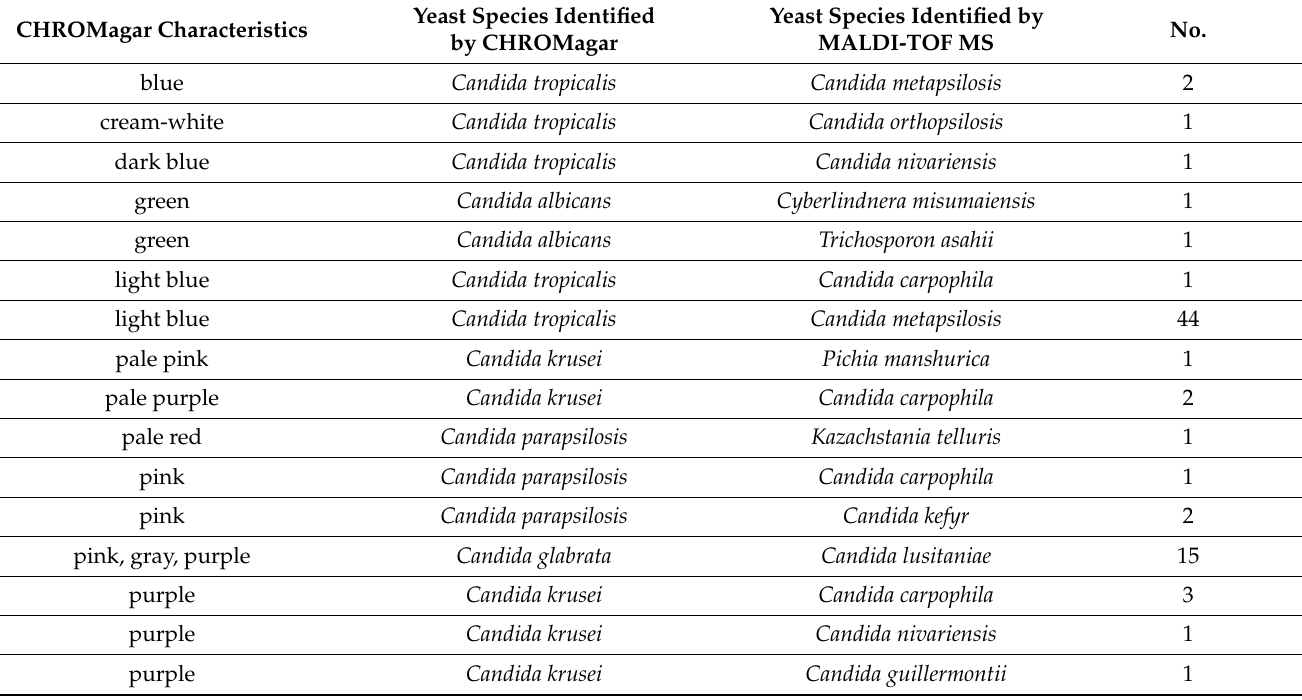
Table 2. Summary of 147 yeast isolates differently identified by CHROMagar and by MALDI-TOF MS.